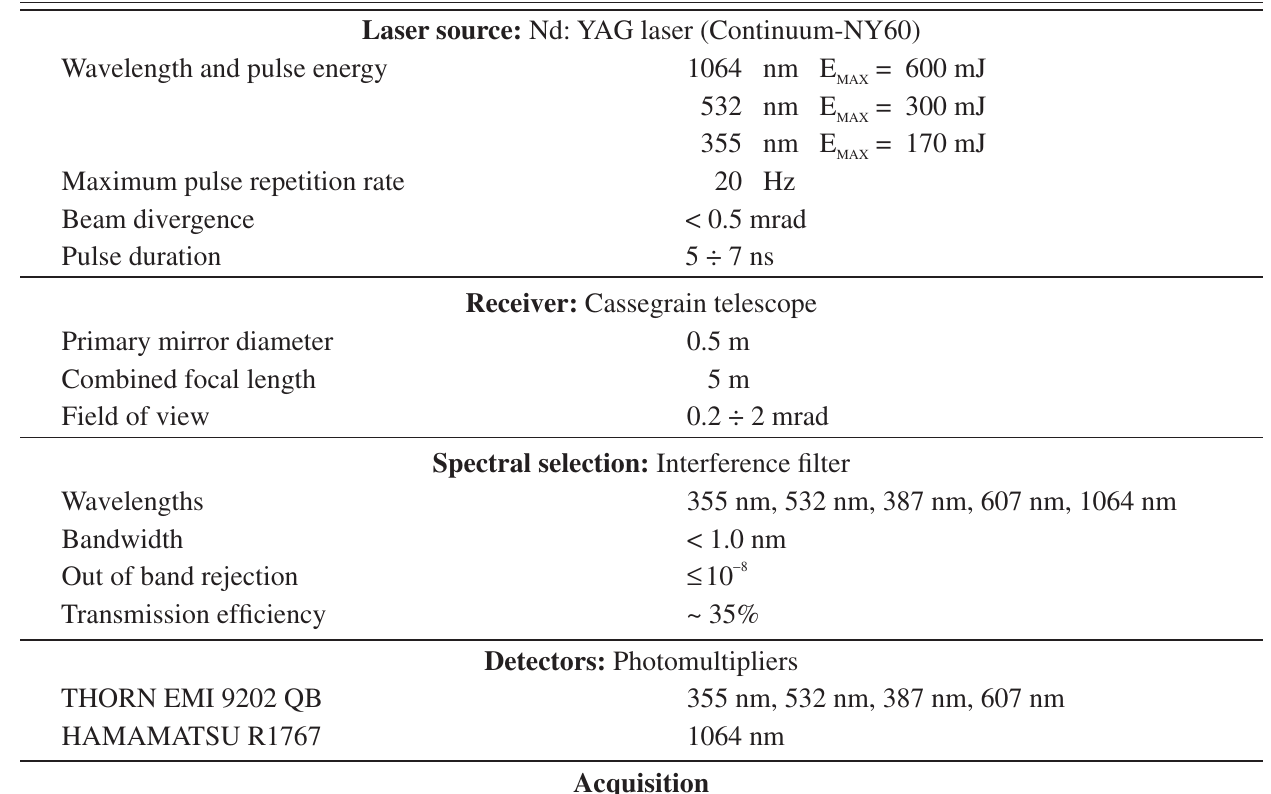
Table II. IMAA-CNR aerosol lidar